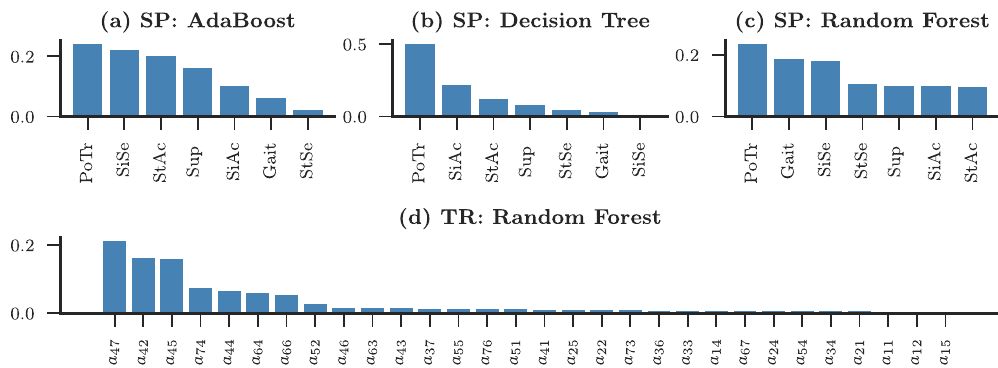
Figure 3. Feature importance. The importance of the features (physical activity states) calculated through the Gini impurity coefficient ( I G ) is shown in decreasing order of their importance. The panels (a–c) represent AdaBoost, Decision Tree and Random Forests respectively for the state probability features. The panel (d) represents the feature ranking for the transition rate matrix